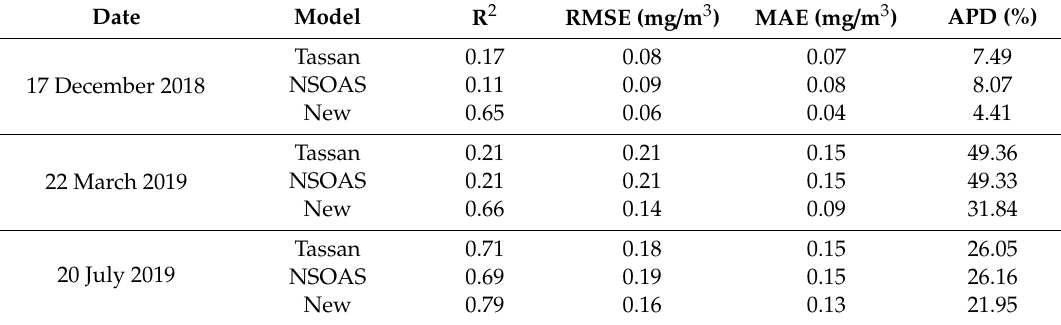
Table 3. Accuracy comparison for Chl-a concentration retrieval using Tassan, NSOAS, and new